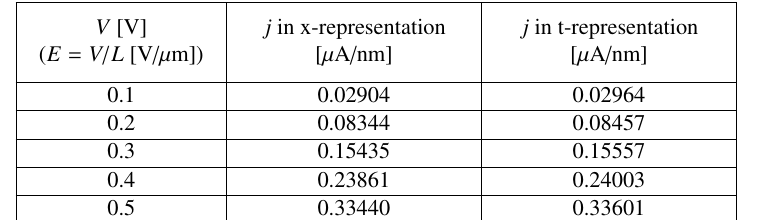
Table 1. Comparison of calculated current density values for a sample with L = 1 . 0 µ m in the range of